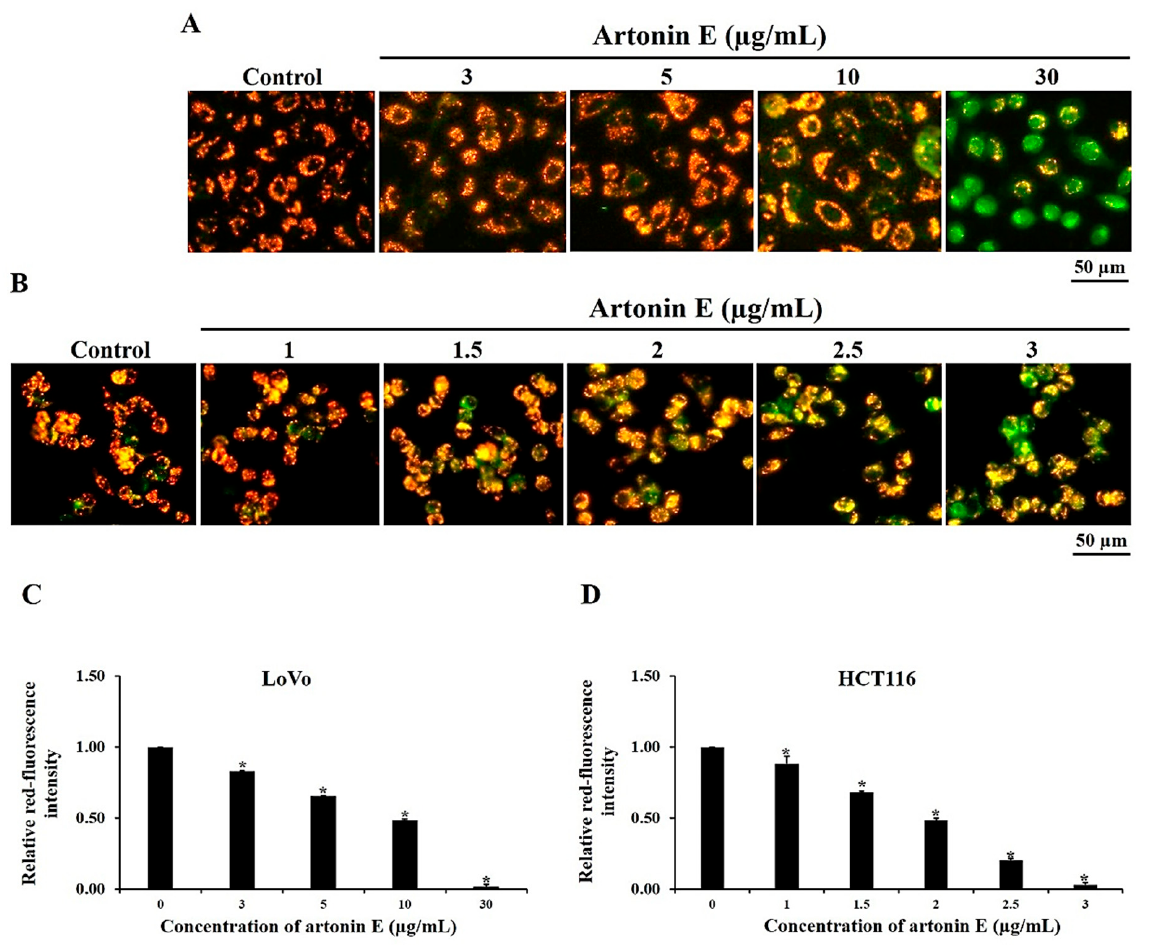
Figure 3. Effect of artonin E on Δ Ψ m in LoVo and HCT116 cells. ( A ) LoVo and ( B ) HCT116 cells were treated with different concentrations of artonin E for 6 h. Artonin E decreased red fluorescence and increased green fluorescence in both ( C ) LoVo and ( D ) HCT116 cells, compared with the control cells. * p < 0.05 compared with the control group.